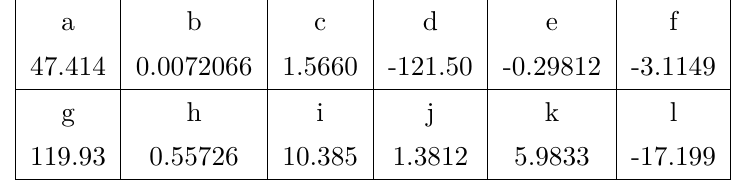
Table 4 . Parameter values using formula A.13 to fit the Next-to-Leading-Log BFKL cross section obtained with the S4 scheme.